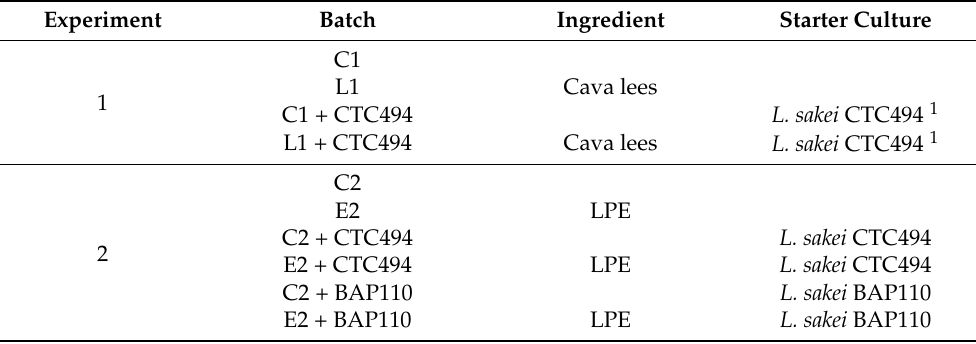
Table 1. Batches of fermented sausages formulated with or without cava lees or the lees phenolic extract (LPE) and/or different strains of L. sakei as the starter